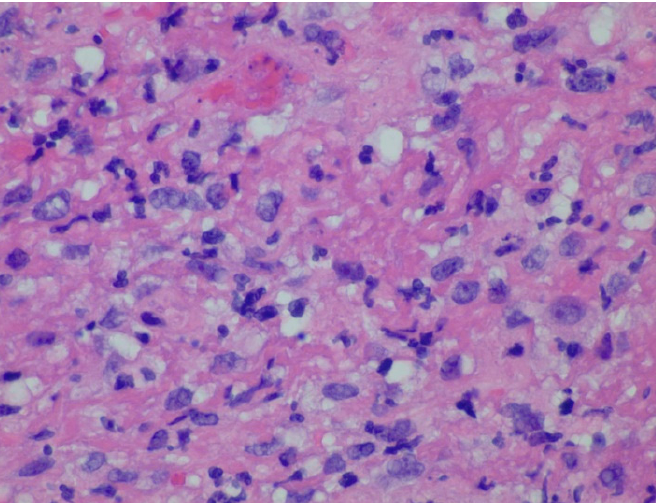
Figure 4. Diffuse infiltration of Renal cell carcinoma cells, clear cell type, with clear and granular eosinophilic cytoplasm in a background of gastric lamina propria seen on Hematoxylin and eosin stain at 600× magnification.